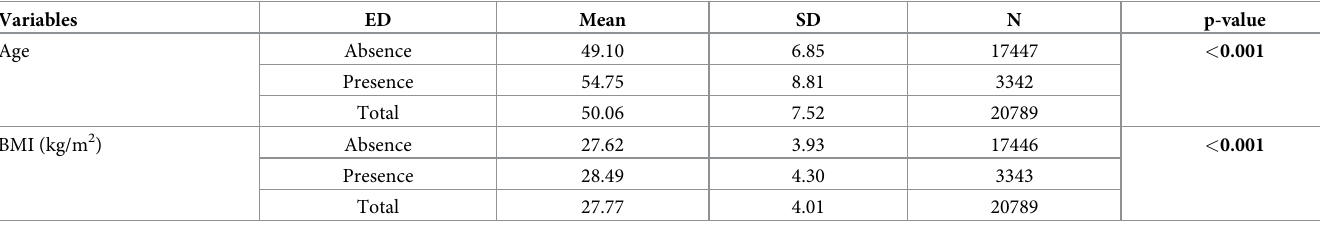
Table 1. Comparison of demographic and clinical variables in relation to ED (n = 20,789).